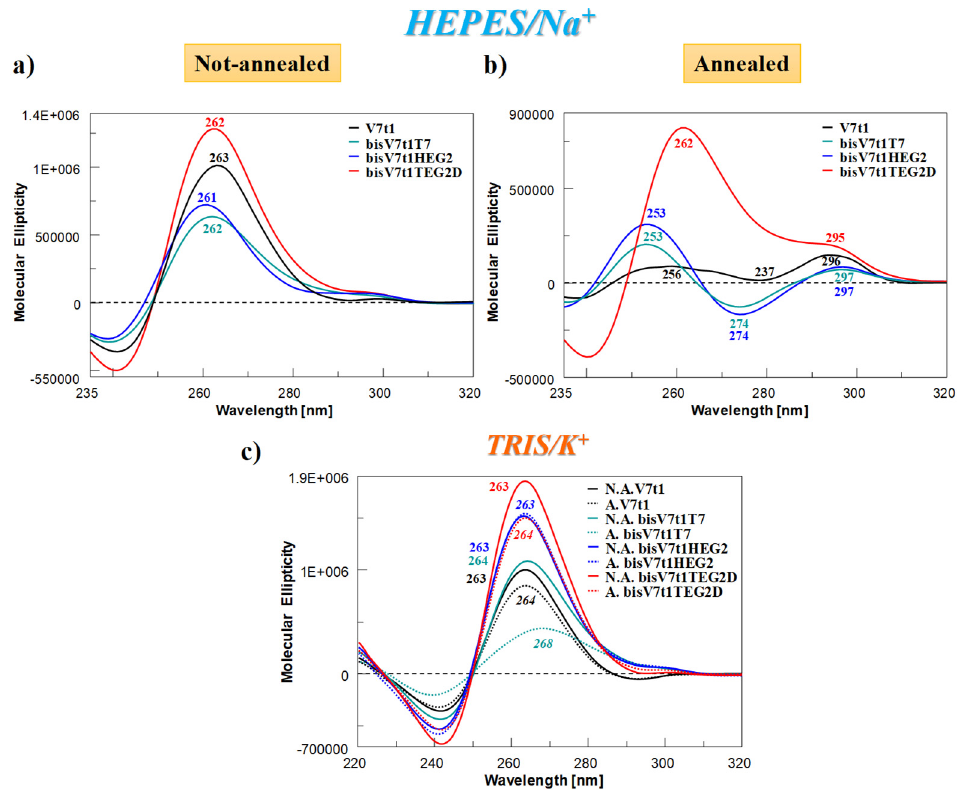
Figure 3. Overlapped circular dichroism (CD) spectra of V7t1 (black line) and covalent V7t1 dimers (green, blue and red lines, respectively for bisV7t1T7 , bisV7t1HEG2 and bisV7t1TEG2D ), recorded at 15 °C and 2 μ M concentration in the selected HEPES/Na + ( a , b ) and TRIS/K + ( c ) buffer solutions. All the investigated oligonucleotides were analyzed in both N.A. and A. form, reported respectively in panel a and b for HEPES/Na + and as continuous and dashed lines in panel c for TRIS/K + buffer solution.